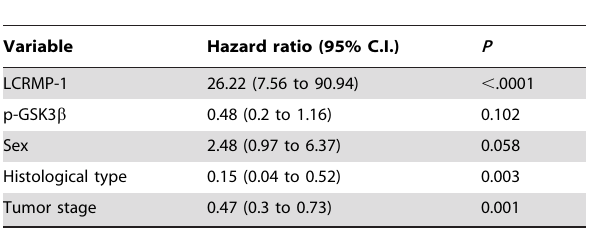
Table 2. Hazard ratios for death (from any cause) among patients with NSCLC, according to multivariable Cox regression analysis*.